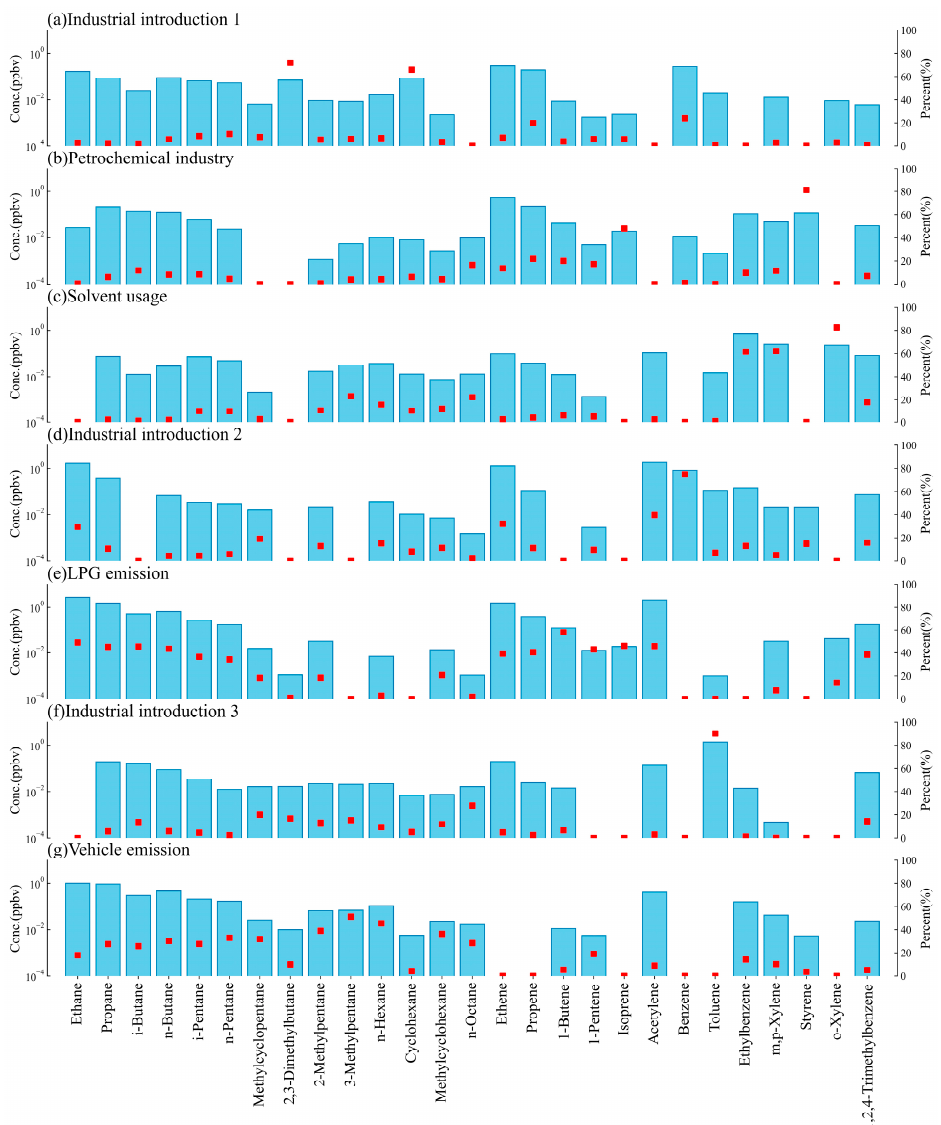
Figure 5. The source profiles (blue bars) and distributions of each species for the different factors (red squares) in the winter. ( a ) Industrial introduction 1; ( b ) Petrochemical industry; ( c ) Solvent usage; ( d ) Industrial introduction 2; ( e ) LPG emission; ( f ) Industrial introduction 3; ( g ) Vehicle emis- sion.